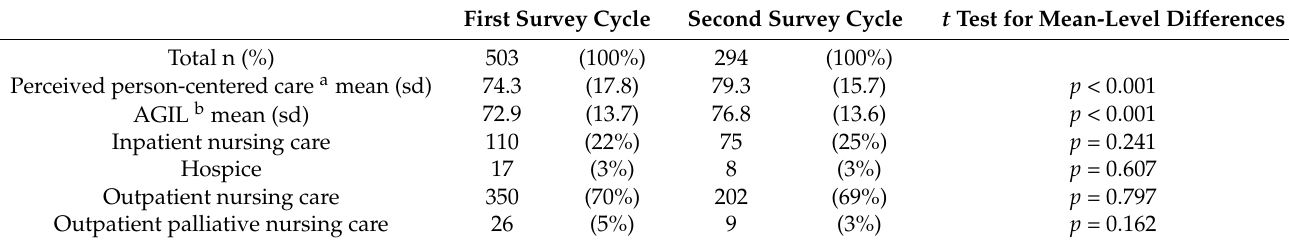
Figure 1. Flow chart of survey participation. Table 3. Sample characteristics by survey cycle.